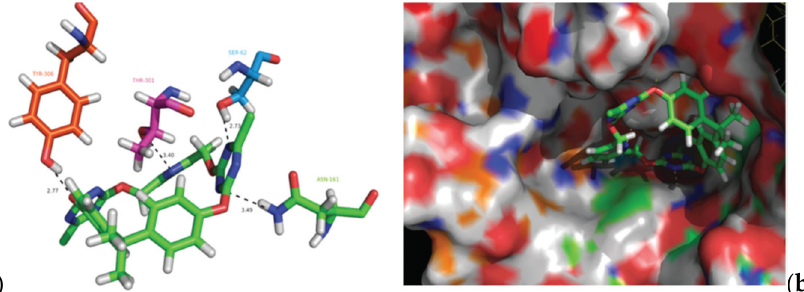
Figure 15. ( a ) Binding of oxacalixarene 151 with the covalent acyl enzyme (PDB ID: 1PW8). ( b ) The oxacalixarene substrate 151 bound to the binding site of quadruple mutant, showing the fitting of the test oxacalixarene on the substrate surface.